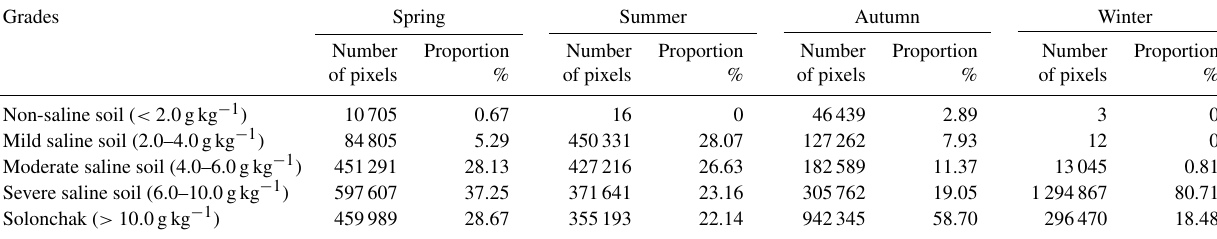
Table 4. The number and proportion of pixels per SSC grade across four seasons. Grades Spring Summer Autumn Winter Number Proportion Number Proportion Number Proportion Number Proportion of pixels % of pixels % of pixels % of pixels